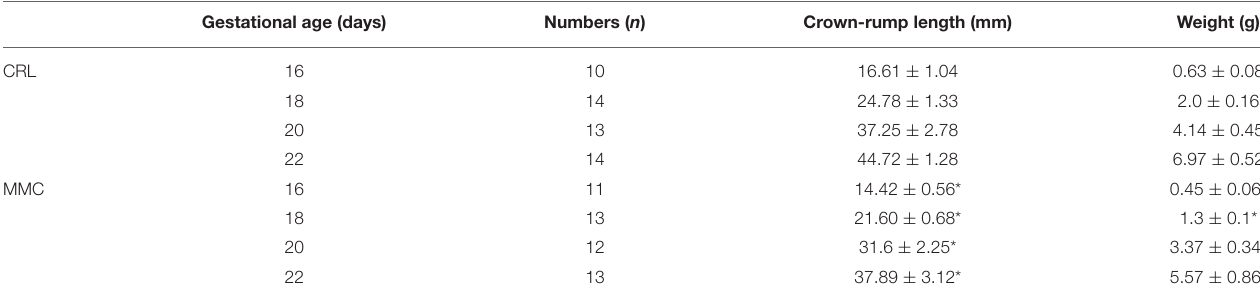
TABLE 3 | Summary of the weight and crown-rump length of fetuses between CRL and